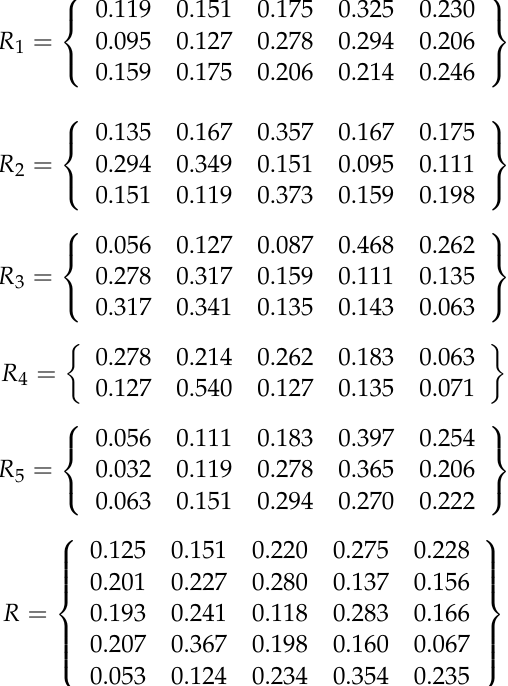
The indicator system of the social stability risks of disaster-preventive migration was divided into two levels. FCE was performed first for second-level indicators and then for first-level